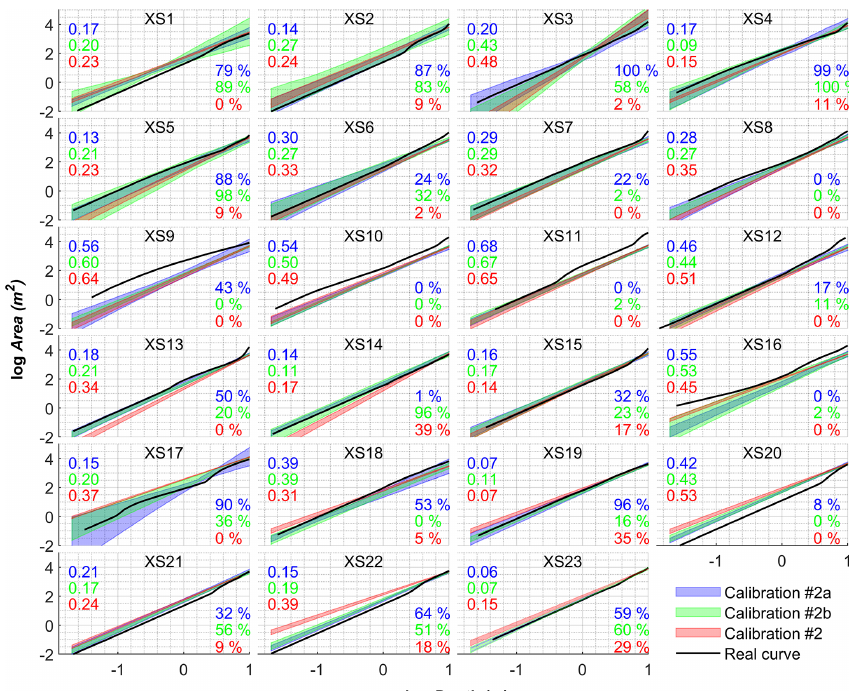
Figure B2. Calibrated curves using three scenarios of width observations only, i.e., one width observation per 5km reach (calibra- tion #2a), one width observation per 2km reach (calibration #2b), and all available widths (calibration #2). The color band represents the mean ± standard deviation based on an ensemble of 10 calibrations. The number of cross-section is given in each plot. RMSE and coverage of calibrated curves against real data are reported on the left and right sides of each plot, respectively. Font color is consistent with the curve color. The average RMSE and coverage values are 0.28, 0.30, and 0.34 and 45%, 36%, and 8% for calibration #2a, #2b, and #2,